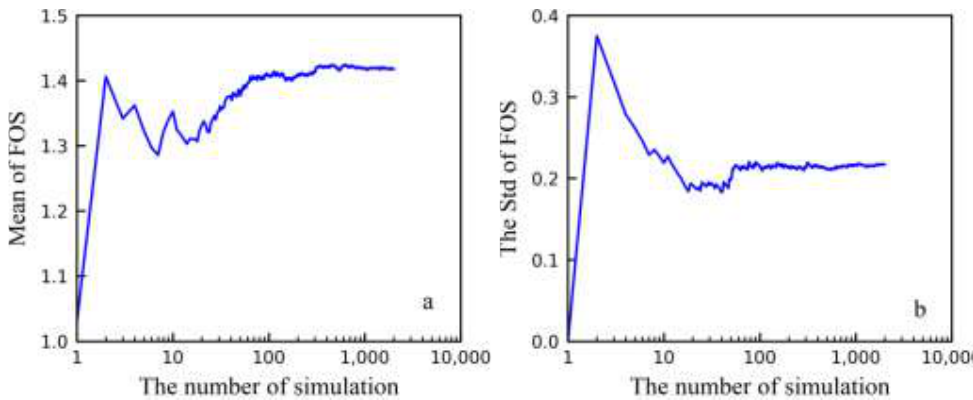
Figure 5. Convergence of FOS using Monte Carlo simulation (( a ) The Mean of FOS for 2000 Monte Carlo simulations; ( b ) The Std. of FOS for 2000 Monte Carlo simulations).